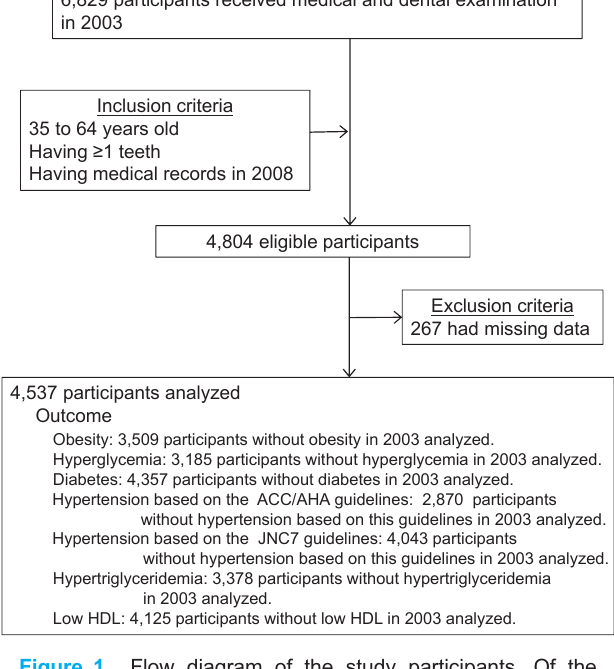
Figure 1. Flow diagram of the study participants. Of